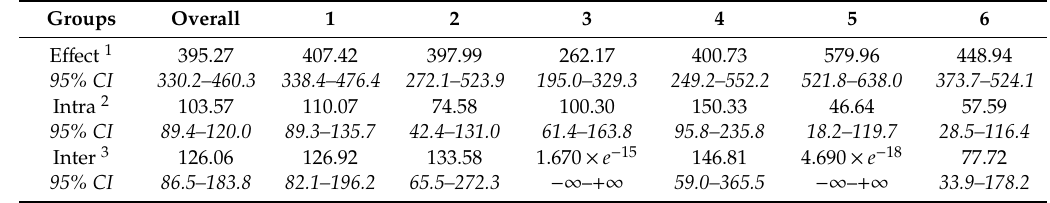
Table 2. Groups 1–6 (as indicated in 2.7) were tested for heterogeneity regarding the outcome.